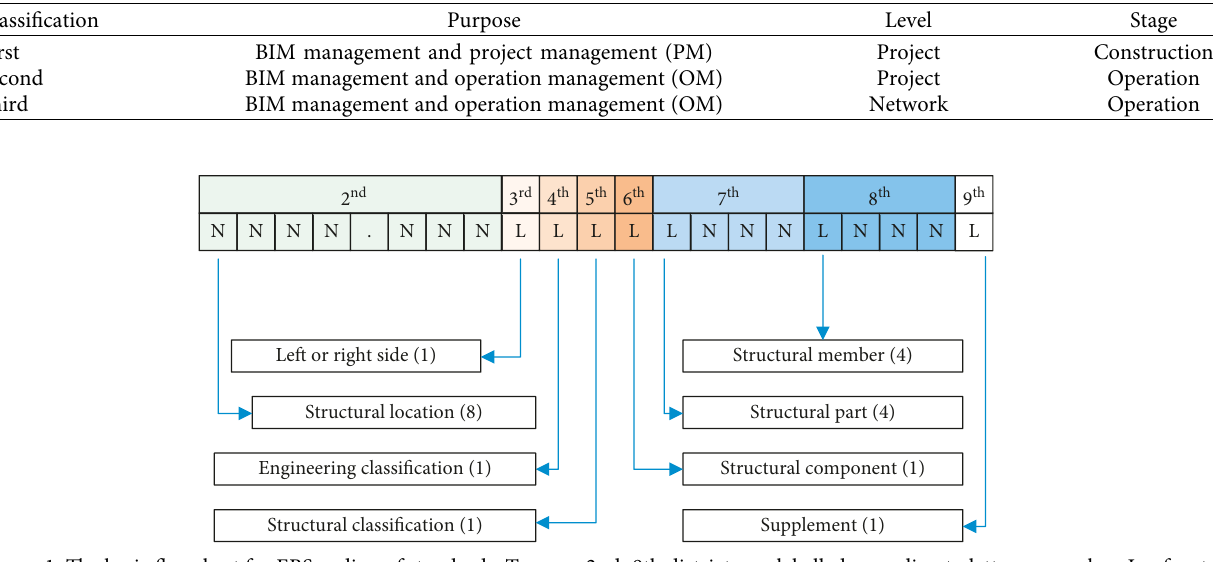
Table 1: EBS coding standard system.